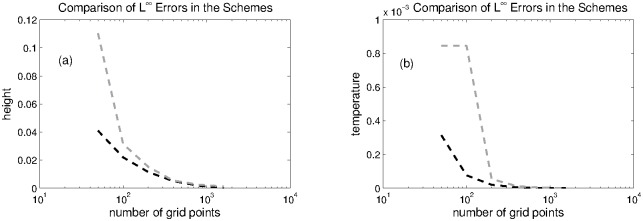
Problem 1: A comparison of L∞ errors in height and temperature of both schemes at different grid points.